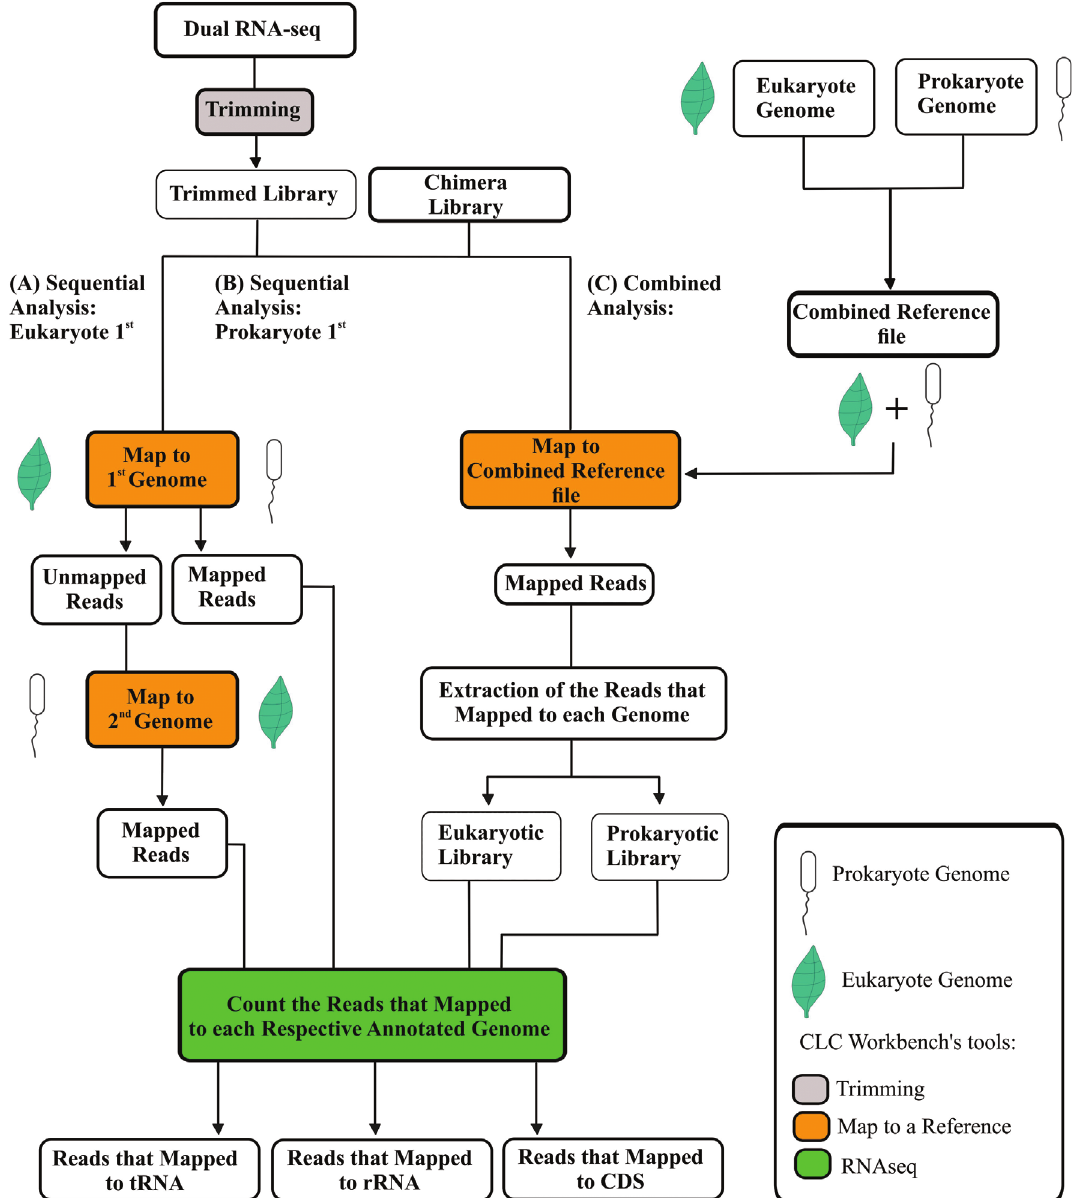
Figure1 -MappingstrategiesforDualRNA-Seqanalysis.(A)Sequentialanalysisaligninglibrariestotheeukaryoticgenomefirst-Eukaryote1 st ;(B)Se- quential analysis aligning libraries to the prokaryotic genome first- Prokaryote 1 st ; (C) Combined